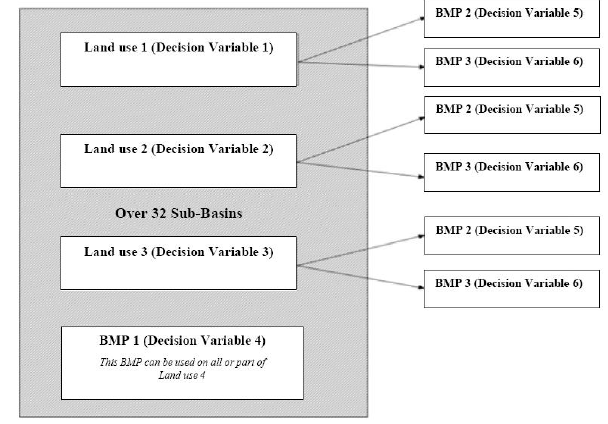
Fig. 4. The schematic of decision variables in each